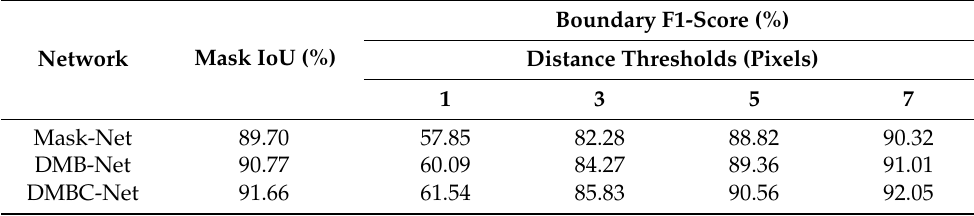
Table 4. Mask IoU and boundary F1-score comparisons for ablation studies of inter-task consistency